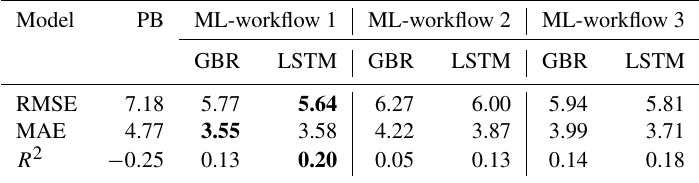
Figure 2. Time series of observed and predicted Chl from GBR and LSTM models in (a) workflow 1 and (c) workflow 3, and the corre- sponding scatter plots of observations vs ML predictions of Chl in workflow 1 and workflow 3 are shown in panels (b) and (d) , with the black and blue dots and lines representing the predictions from GBR and LSTM, respectively. Panel (e) shows the observed and predicted algal bloom onsets in 2017–2020 using the same colour coding as the previous panels. Results from the PB model simulation in Mesman et al. (2022) are also shown in (c) and (e) . Table 2. Comparisons of model performance during the testing period based on RMSE, MAE, and R 2 . The unit of Chl is milligrams per cubic metre (mgm − 3 ). In bold are the best fits of each statistical metric. For comparison of training and testing periods, see Table